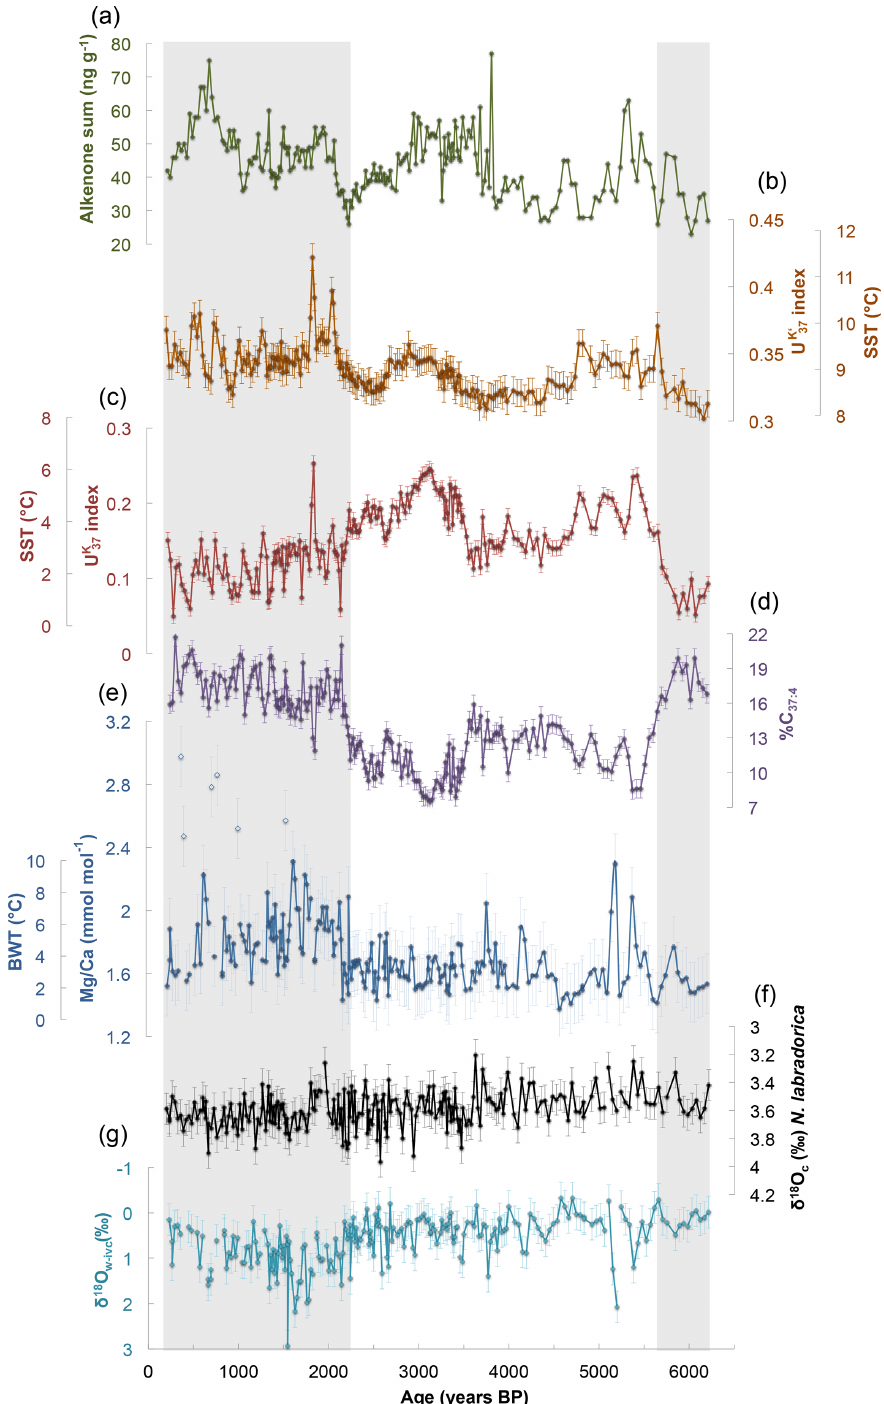
(cid:48) index displayed with 0.01 uncertainty, and respective Figure 4. Down-core record of MSM45-31-1 showing (a) alkenone sum, (b) U K 37 SST estimates, (c) U K index displayed with 0.01 uncertainty and respective SST estimates, (d) %C 37 : 4 displayed with 0.8% uncertainty, 37 (e) Mg / Ca (mmolmol − 1 ) of N. labradorica displayed with 0.19mmolmol − 1 uncertainty and respective BWT estimates, (f) δ 18 O calcite (‰- V-PDB) of N. labradorica displayed with 0.11‰ uncertainty, and (g) δ 18 O w-ivc (‰-V-SMOW) displayed with 0.35‰ uncertainty. Grey vertical bars highlight periods of pronounced oceanographic